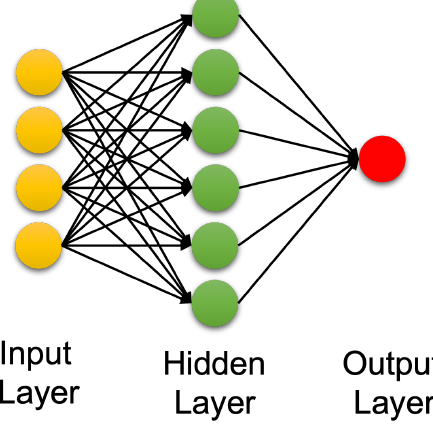
Figure 2. Conventional artificial neural